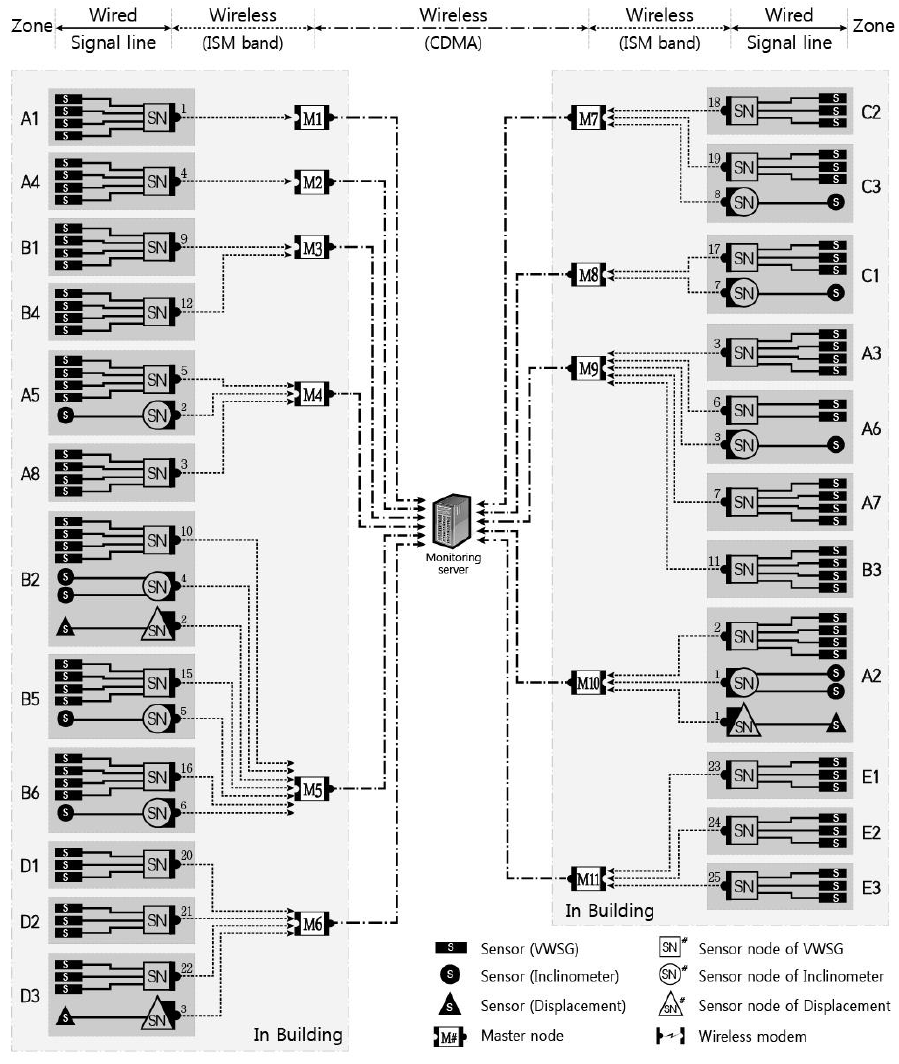
Figure 10. Communication network architecture at